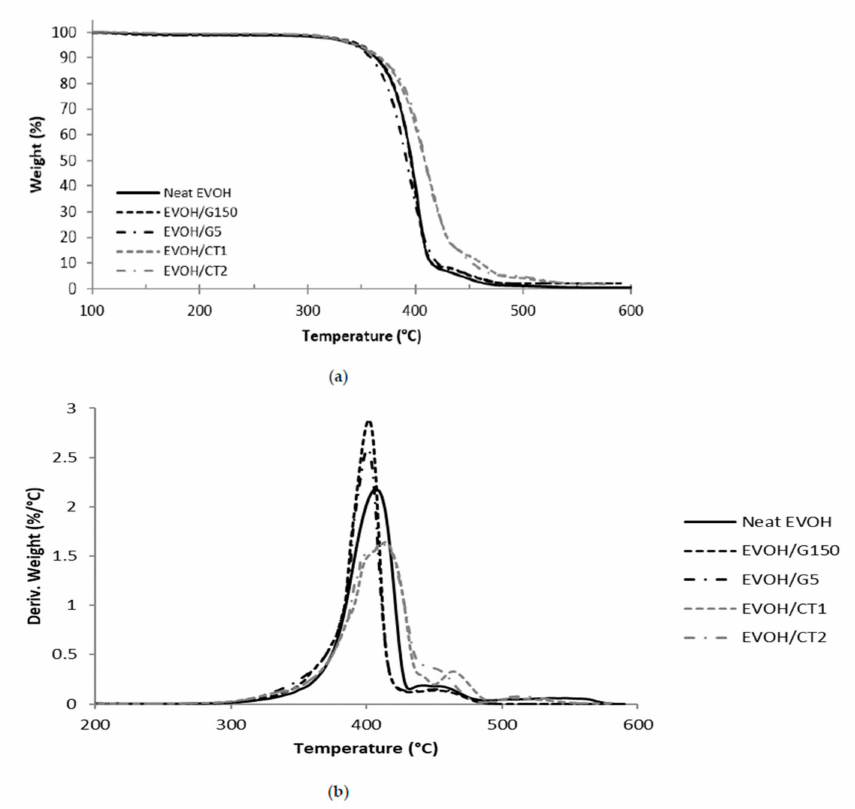
Figure 4. Representation of ( a ) weight loss curves and ( b ) first derivative weight loss curves of neat EVOH and studied nanocomposites (20 ◦ C · min − 1 , filler rate = 2 wt%).